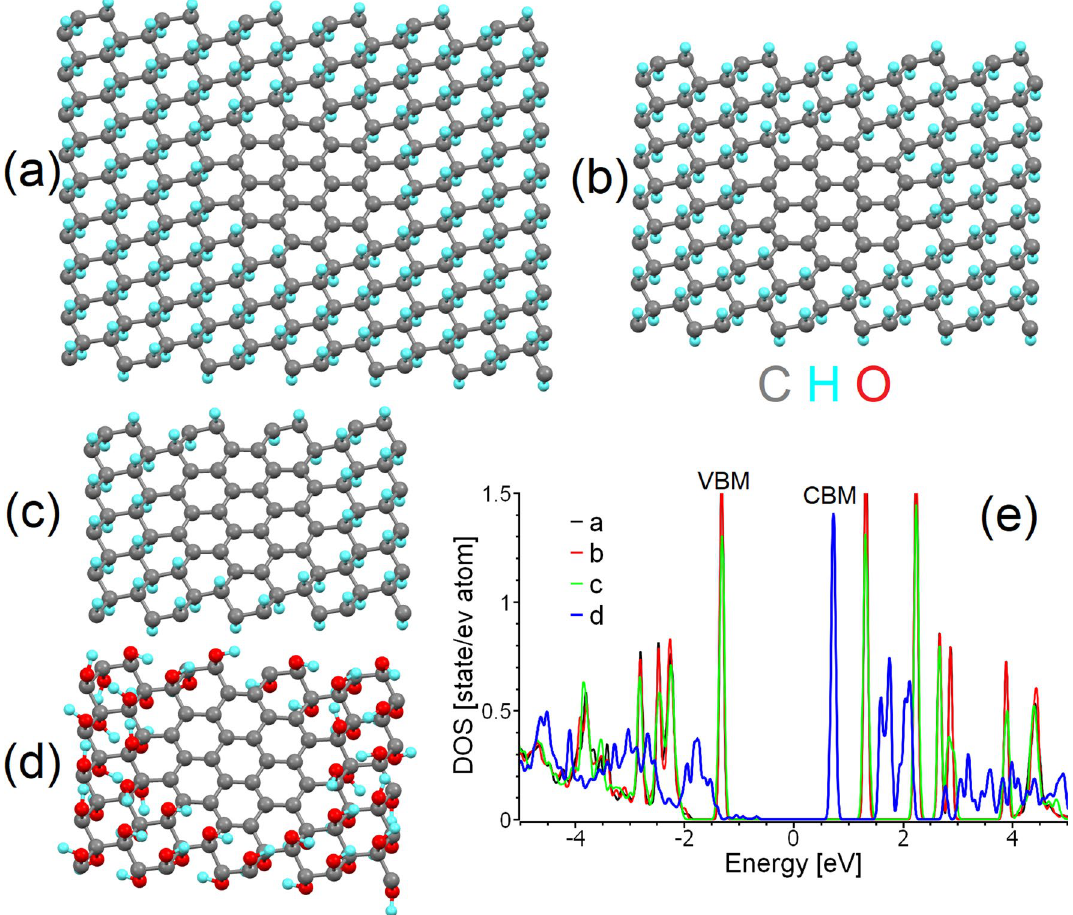
Fig. 1 Optimised atomic structure of a sp 2 -island of 24 carbon atoms inside a large, b medium and c small supercells of graphane, and d a small supercell of graphene oxide. Carbon atoms are shown in grey, hydrogen in cyan, and oxygen in red. The same colour scheme is used in all further figures herein. e The densities of states of carbon atoms in the sp 2 -islands in ( a – d ). The Fermi energy in ( e ) and in similar